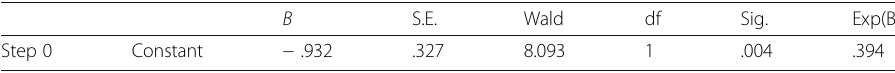
Table 17 Variables in the equation